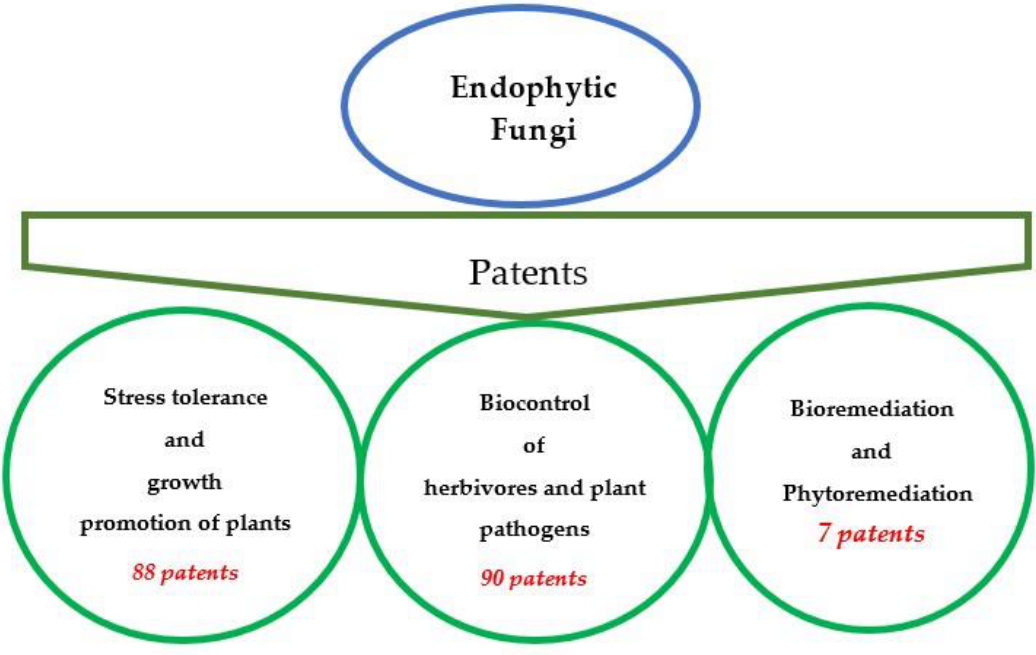
Figure 2. Total number of patents for area of application in the period 1988 to 2019.